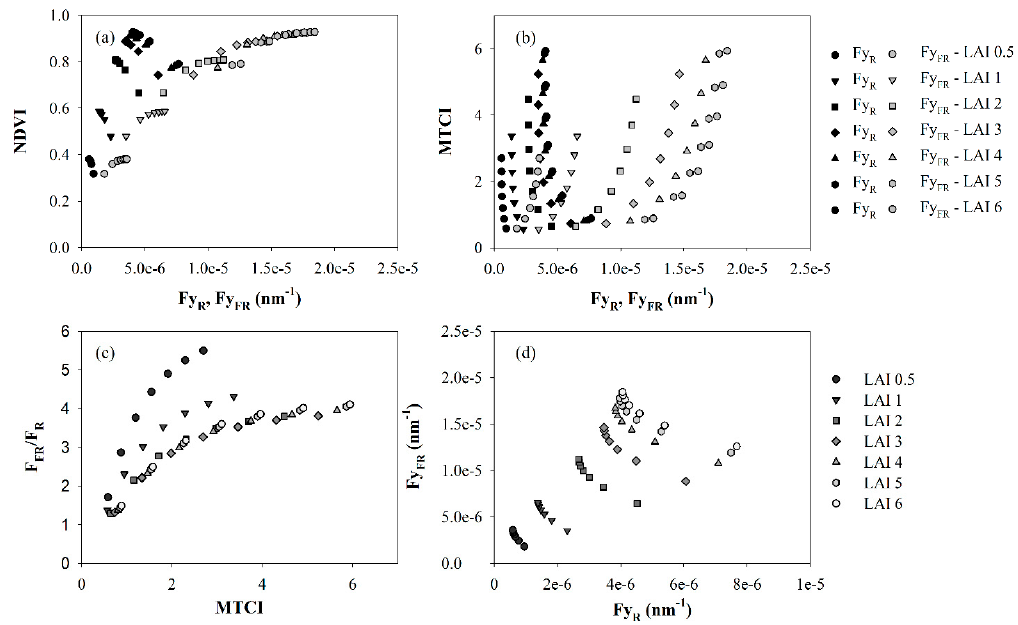
Figure 6. Simulated data. Relationships between: ( a ) Fy R , Fy FR and NDVI; ( b ) Fy R , Fy FR and MTCI; ( c ) F FR /F R ratio and MTCI; and ( d ) Fy R and Fy FR computed from the SCOPE simulations.